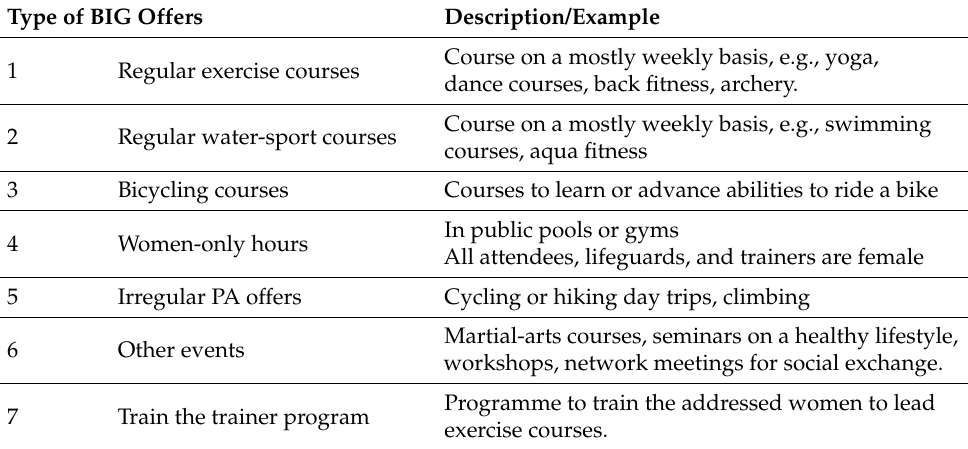
Table 1. Descriptions and examples for different types of BIG offers that were implemented at the